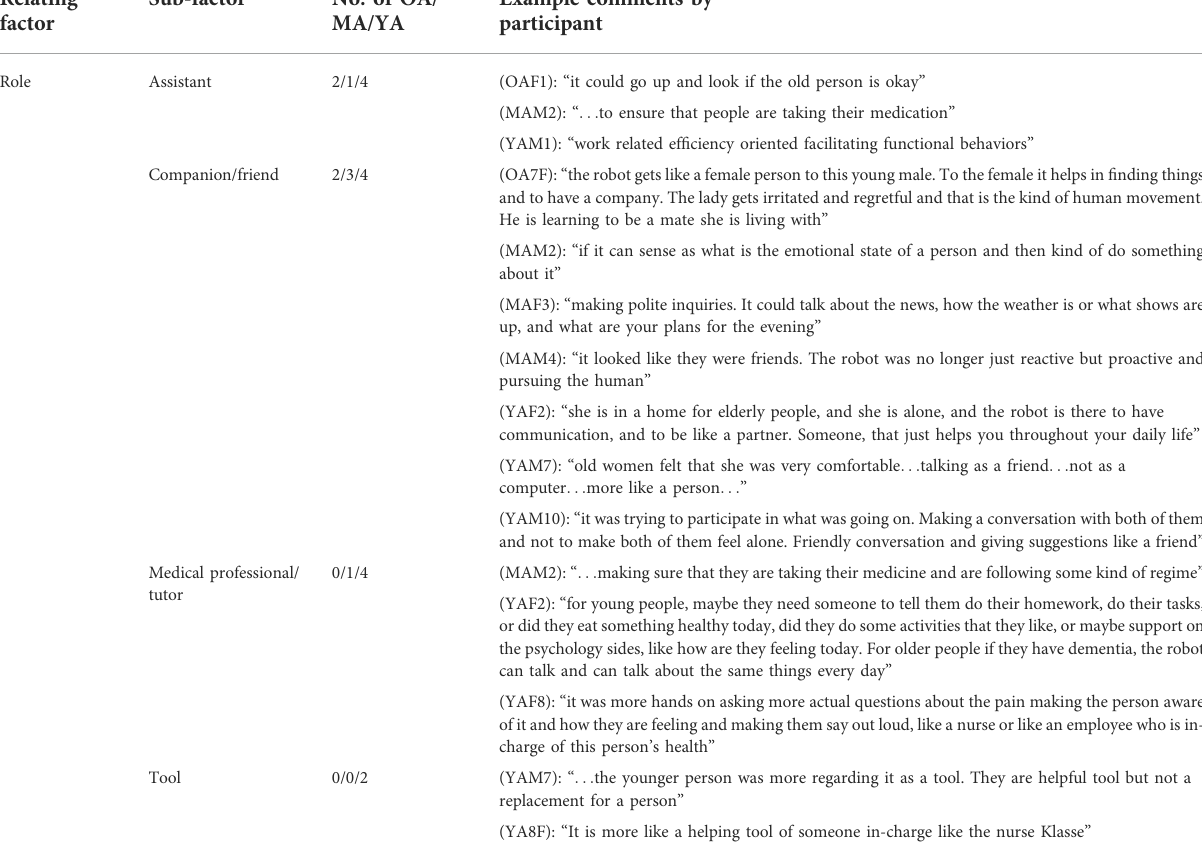
TABLE 5 Relating — Role: First and second columns list the factors, which were perceived contributing to breakdown situations categorized into the theme relating. The third column shows the number of older adults (OA) middle-aged (MA) and younger adults (YA) who commented on each factor, and the fourth column provides examples of